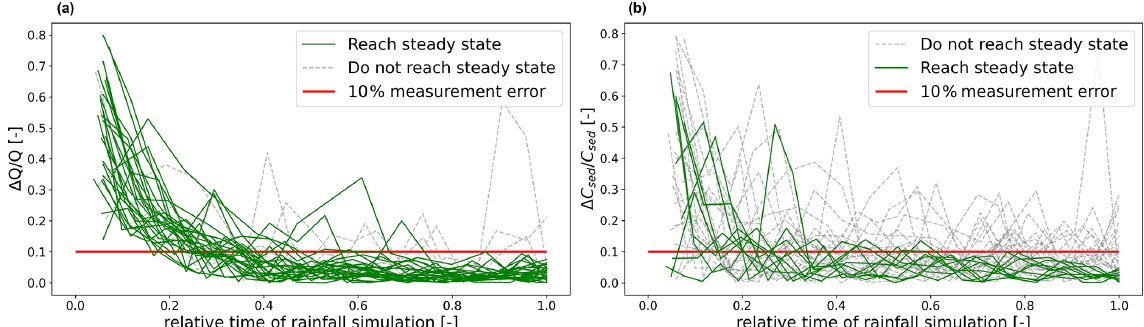
Figure 6. Classification of rainfall simulation experiments, where green lines reach steady state during 0.75–1.0 of relative time of rainfall simulation: (a) relative change of discharge and (b) relative change of sediment concentration.